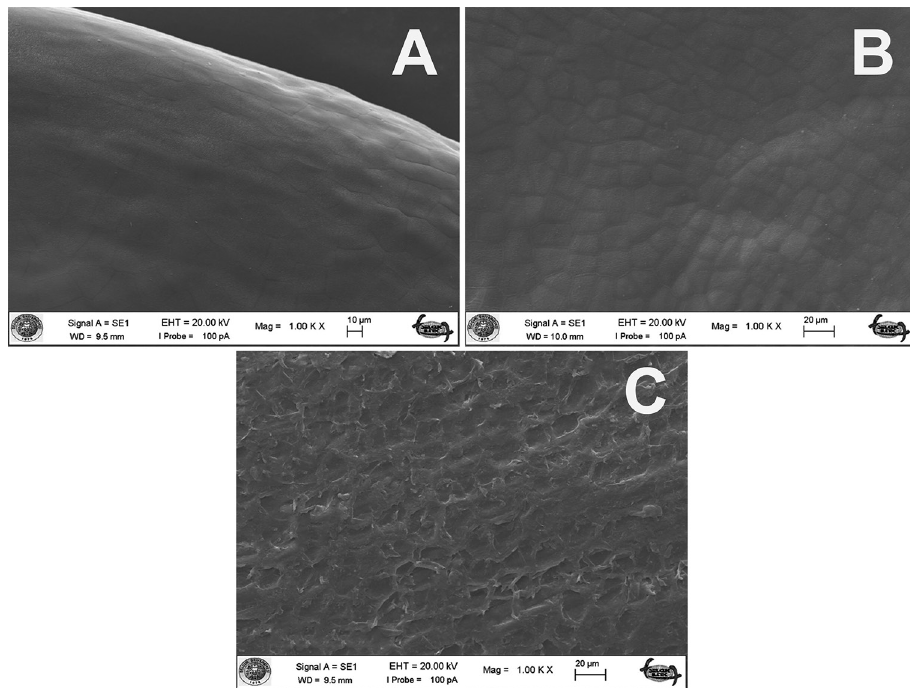
Figure 6. Scanning electron micrographs of seeds sculpturing patterns Linum species A L. aksehirense B L. anisocalyx C L. pubescens